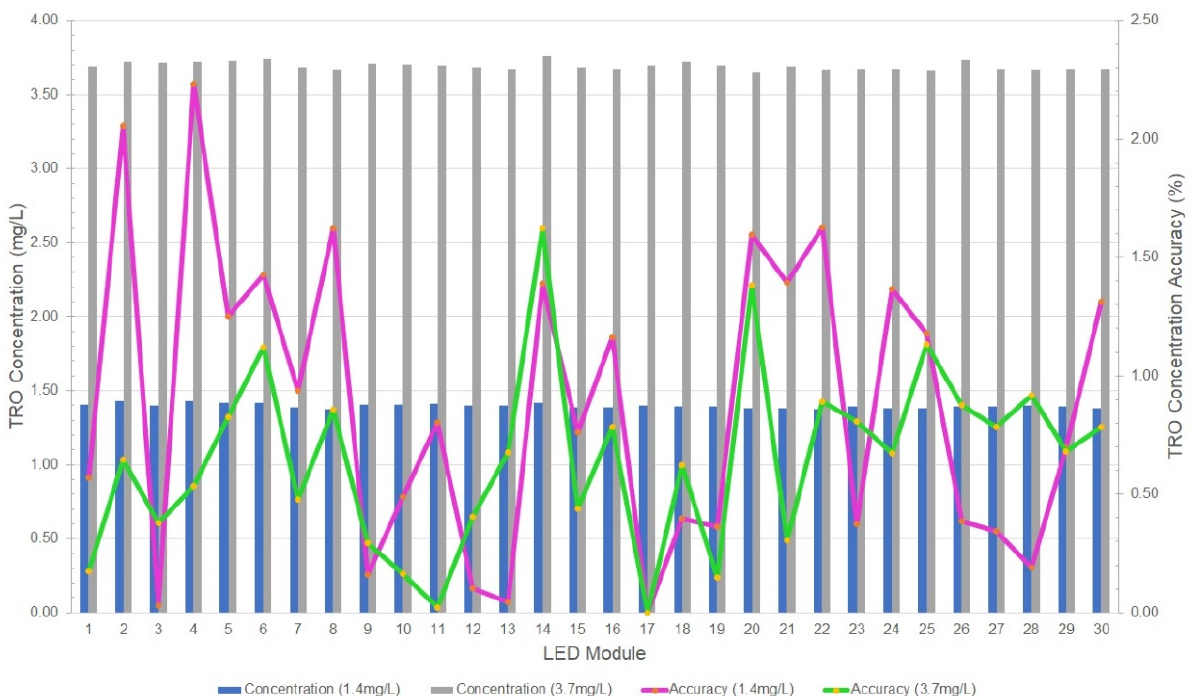
Figure 13. TRO concentration and accuracy with the proposed algorithm. Table 2. Measurement accuracy and precision result of TRO concentration applying the pro- posed algorithm. Parameter No Calibration